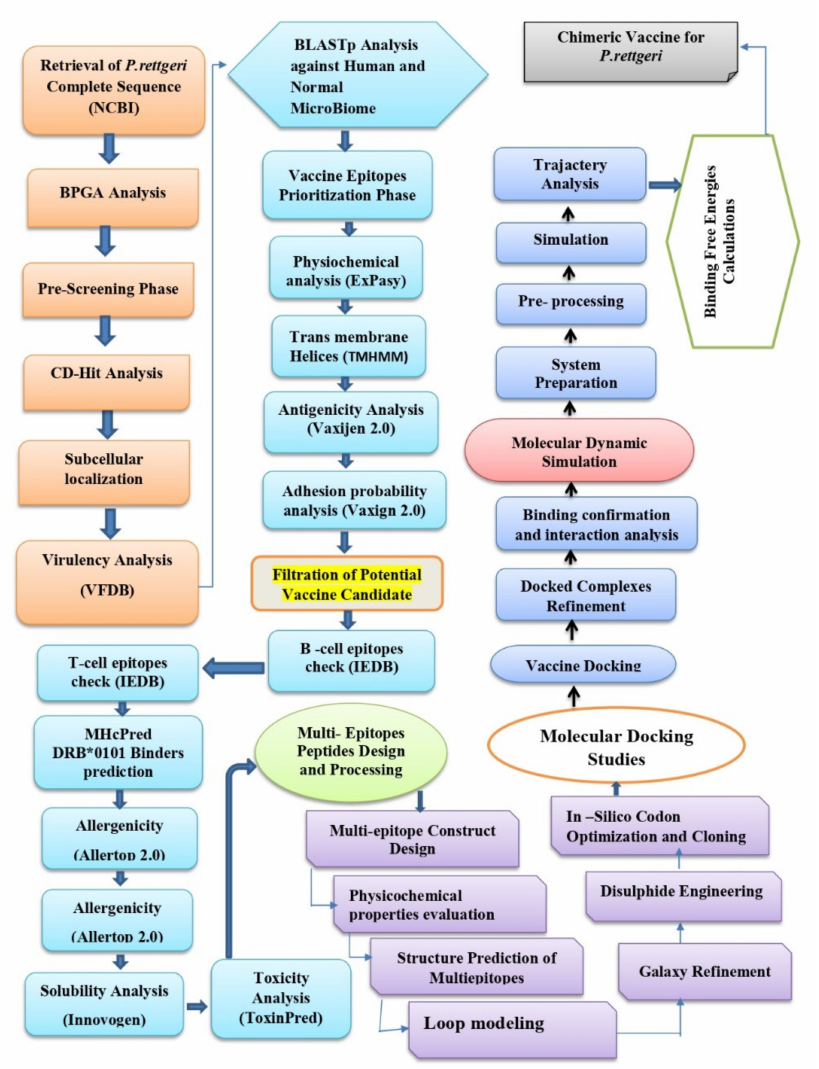
Figure 1. Overall flow of methodology that was used in the design of the multi-epitope vaccine against P. rettgeri